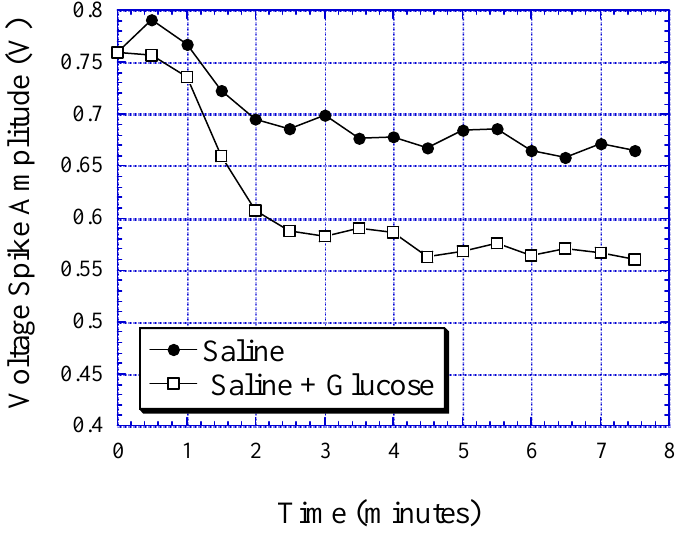
Figure 4. Measured voltage spike amplitude of a magnetostatic sensor as a function of time and glucose concentration. The sensors is placed in either a pure saline solution, or buffered saline containing 100 mg/L